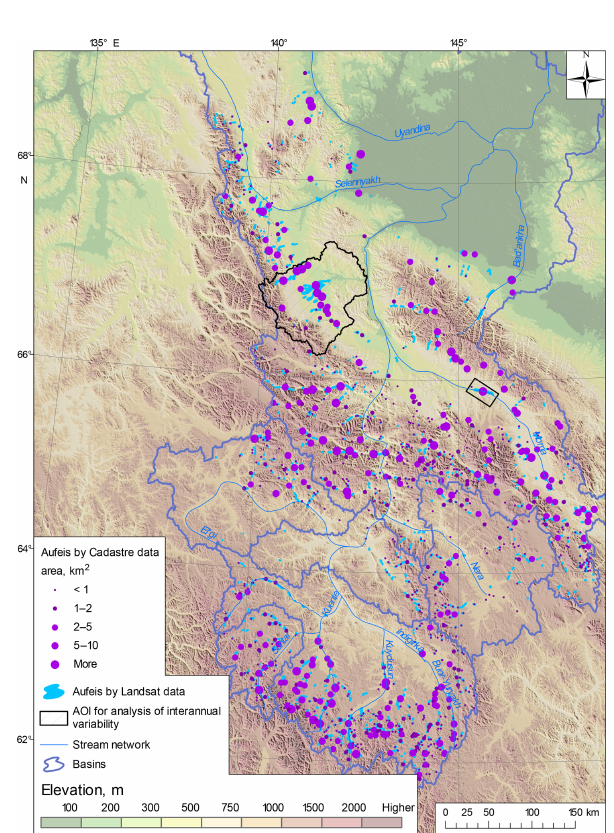
Figure 8. Aufeis in the Indigirka River basin according to the Cadastre and Landsat images. Black outlines represent the zones where aufeis area interannual variability was assessed.